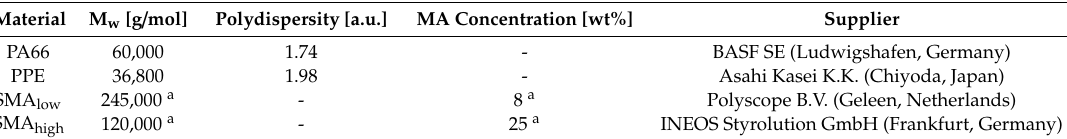
Table 1. Properties of blend components. PA66: polyamide 66, PPE: poly (2,6-dimethyl-1,4-phenylene ether), SMA: styrene–maleic anhydride copolymers. Material M w [g / mol] Polydispersity